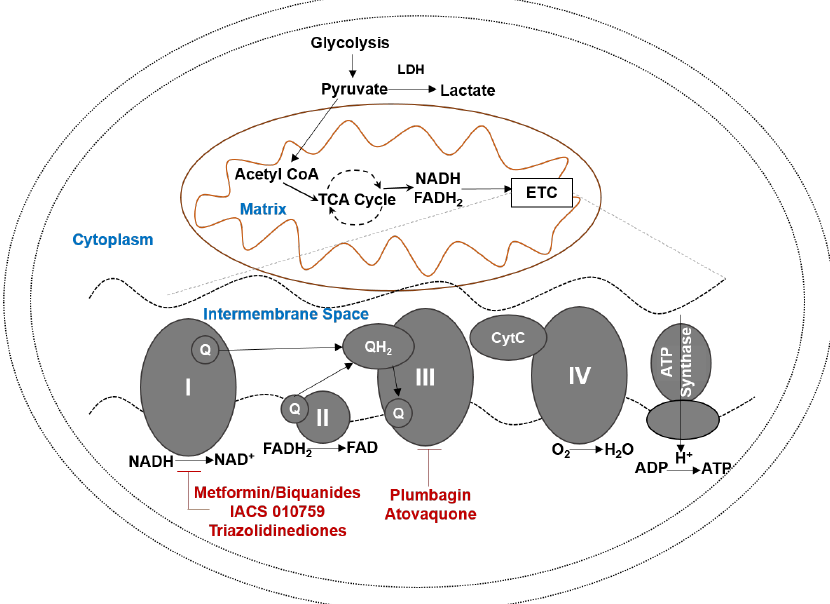
Figure 1. Oxidative phosphorylation. Aerobic glycolysis metabolizes glucose to lactic acid. Oxidative phosphorylation (OXPHOS) occurs in mitochondria and leads to efficient generation of ATP. OXPHOS is an active pathway in tumors and cancer stem cells. Several inhibitors or the various subunits of the mitochondrial electron transport complexes can serve as candidates for tumor therapy. Prominent drug candidates for HGSOC are shown. CytC, Cytochrome C, ETC, Electron Transport Chain, LDH, Lactate Dehydrogenase, Q, unbiquinone, QH2, Ubiquinol, TCA, Tricarboxylic Acid Cycle, FADH 2 , Flavine Adenine Dinucleotide, NADH, Nicotinamide Adenine